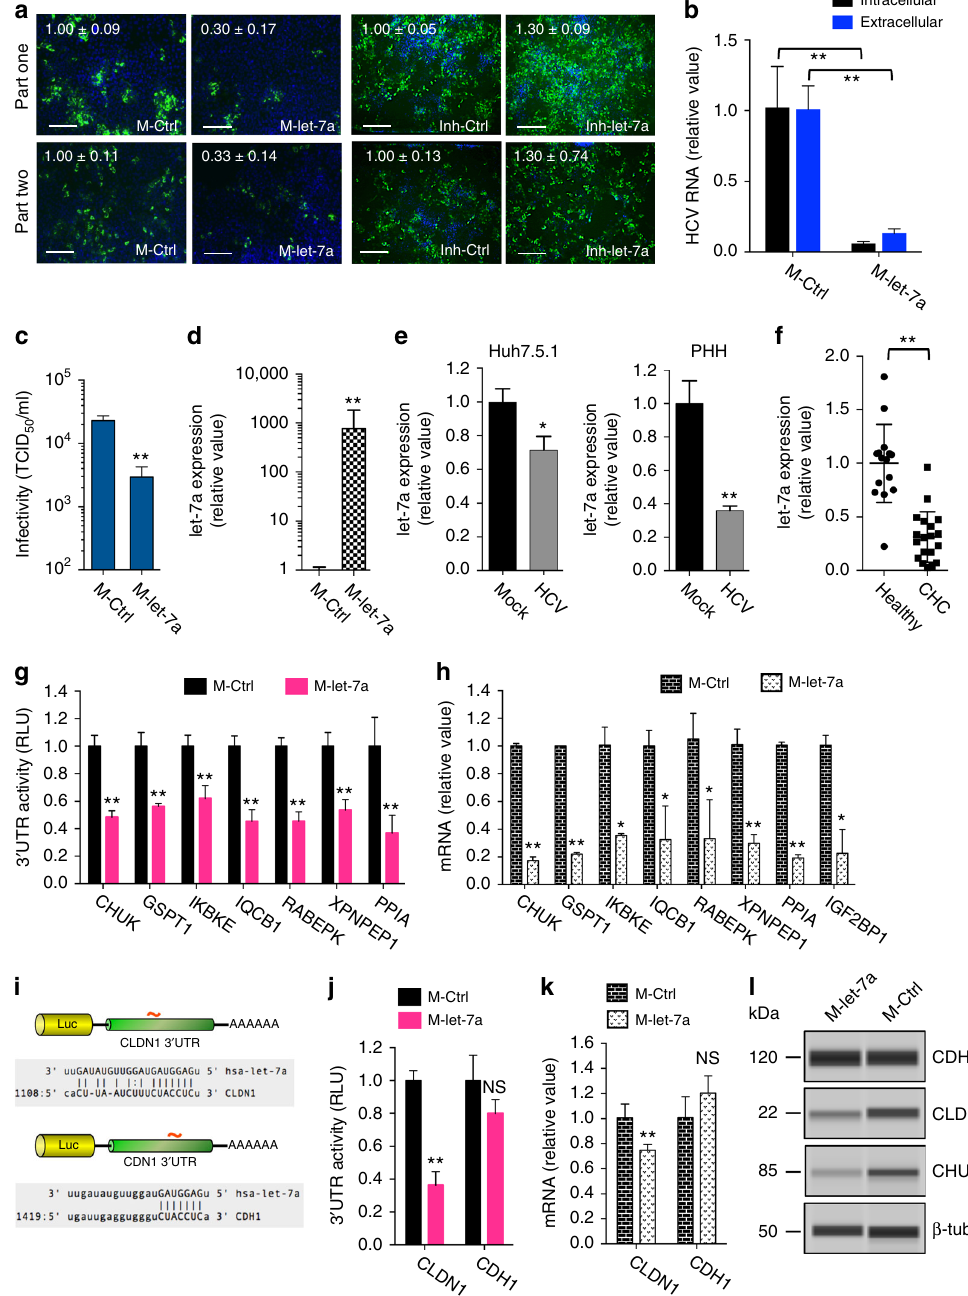
Fig. 5 let-7a targets various HCV host dependencies to inhibit multiple steps of HCV infection. a – c Effects of let-7a mimic transfection on productive HCV infection. a Representative images and quantitative analyses of HCV core staining in Huh7.5.1 cells transfected with mimic control (M-Ctrl) or let-7a, for part one and part two of the screen. Green, HCV core; blue, nuclei. Scale bars, 100 μ m. b Quanti fi cation of intracellular and extracellular HCV RNA levels after let-7a mimic treatment. c let-7a mimic transfection suppresses HCV infectivity, demonstrated by TCID 50 assay. d Transfection ef fi ciency of let-7a mimic, determined by Q-PCR. e HCV infection decreases let-7a expression in Huh7.5.1 cells and PHH. f Hepatic expression levels of let-7a are signi fi cantly lower among CHC patients compared to healthy controls, measured by Q-PCR. Dots represent assessed individuals. g , h Validation of let-7a cellular targets. 3 ′ -UTR activities ( g ) and mRNA levels ( h ) of various indicated targets were shown downregulated by let-7a mimic transfection. i – l let-7a speci fi cally represses CLDN1 expression to inhibit HCV entry. i CLDN1 and CDH1 each contain one predicted let-7a binding site in the 3 ′ -UTR. j Effect of let-7a transfection on CLDN1 and CDH1 3 ’ UTR activities. k Effect of let-7a transfection on CLDN1 and CDH1 mRNA levels. l Effects of let-7a transfection on protein levels of various indicated targets, determined by western blot. β -tubulin was used as a loading control. kDa kilo Daltons. Values are normalized relative to M-Ctrl, and error bars represent SD of the mean, n = 3 ( a – e , h , k ) or 5 ( g , j ). * P < 0.05, ** P < 0.01 determined by Student ’ s t -test. NS not signi fi